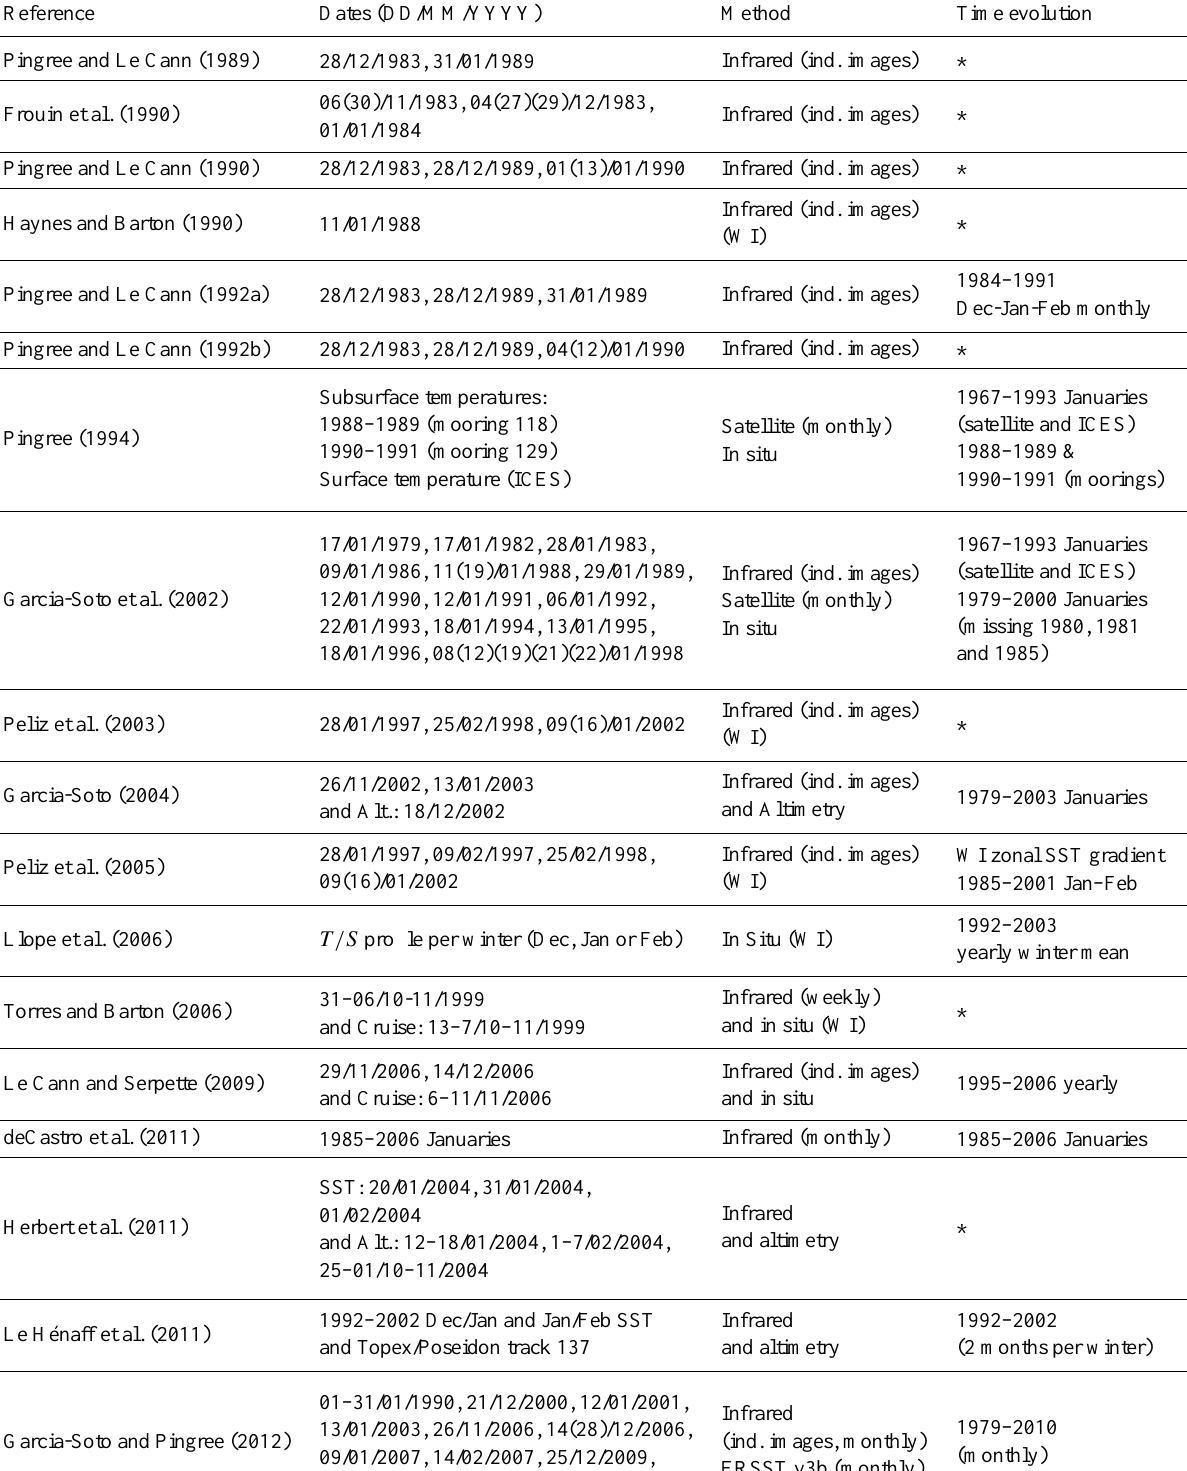
Table 2. The references, dates and the employed technique for the documented IPC and IPC-Navidad detections during the last decades. Only detections from the months taken into account in this study are shown (Nov-Dec-Jan-Feb). A brief description is given whenever the number of dates is very high. Studies that do not take into account the inner part of the Bay of Biscay, i.e. limited to the western or north-western Iberian coasts are identified by the WI acronym (IPC cases, not